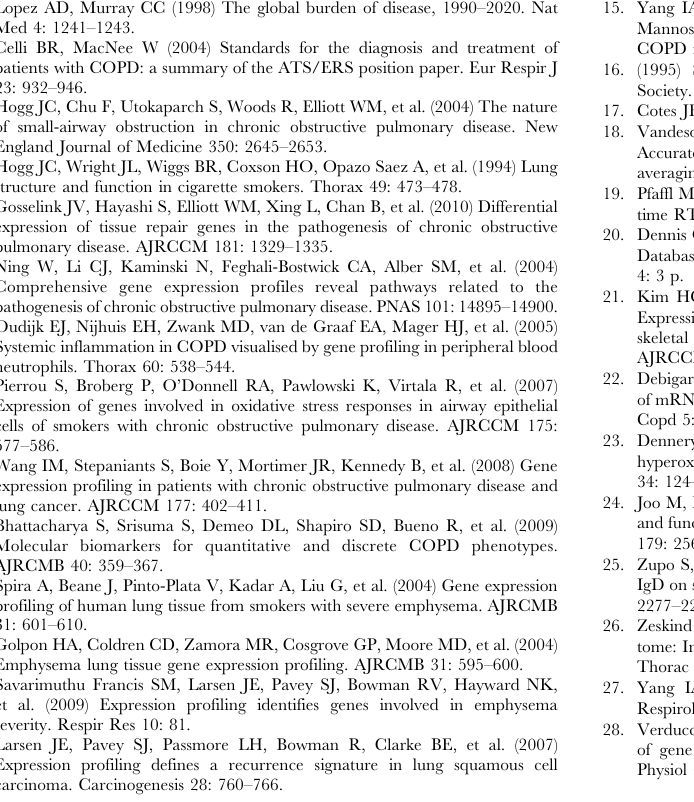
Table S6 Gene ontologies enriched in Bhattacharya et al FEV 1 dataset.